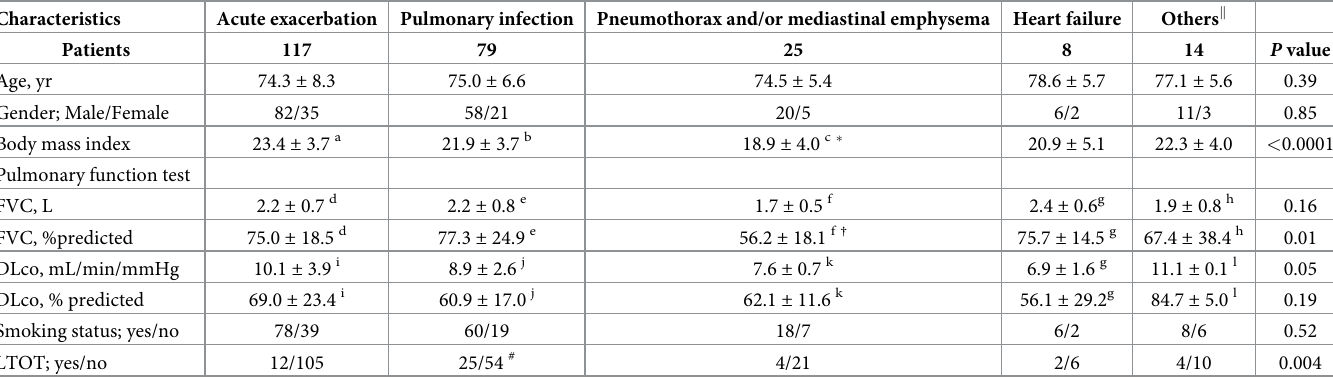
Table 2. Baseline characteristics of patients before the first hospitalization by cause.